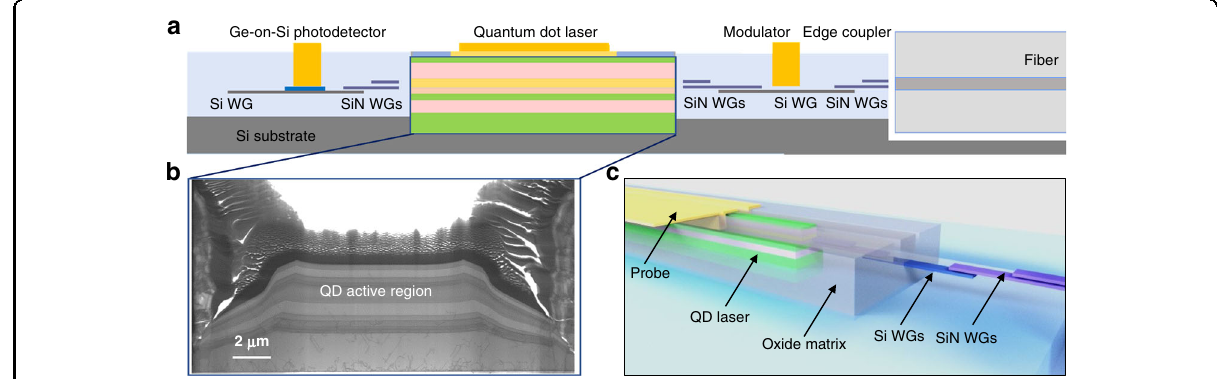
Fig. 6 Heteroepitaxial laser integration on Si photonic platform. a Schematic diagram of the heteroepitaxial laser integration on Si platform. b Cross-section TEM of full laser epi in the pockets grown on 300 mm Si from IQE. c Schematic of intended device con fi